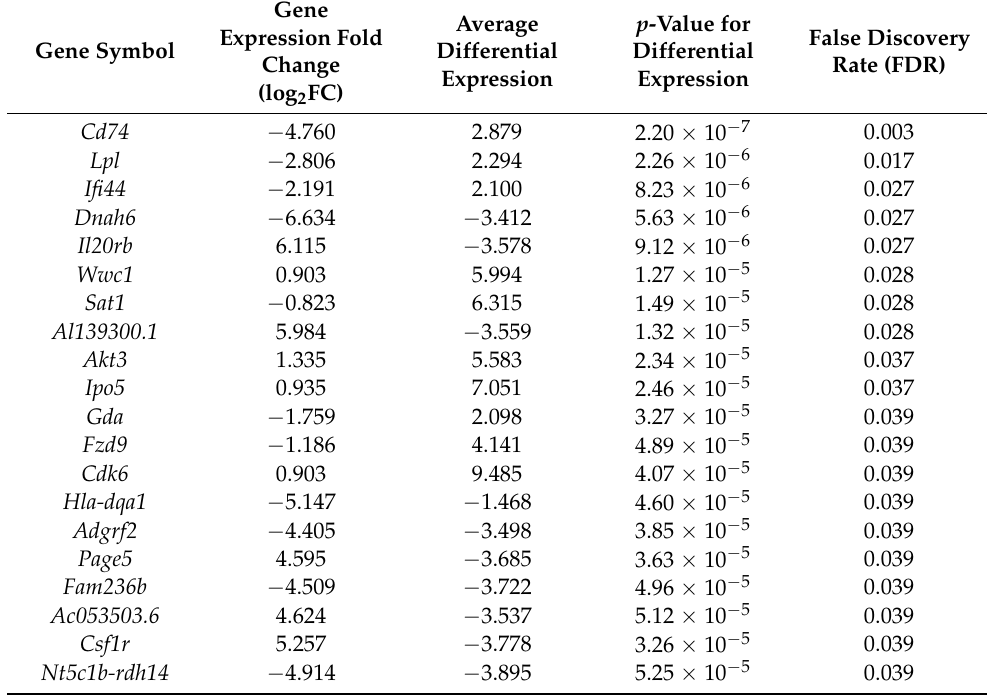
Table 1. The top DEGs in response to dietary soybean GE treatment assorted by p value.